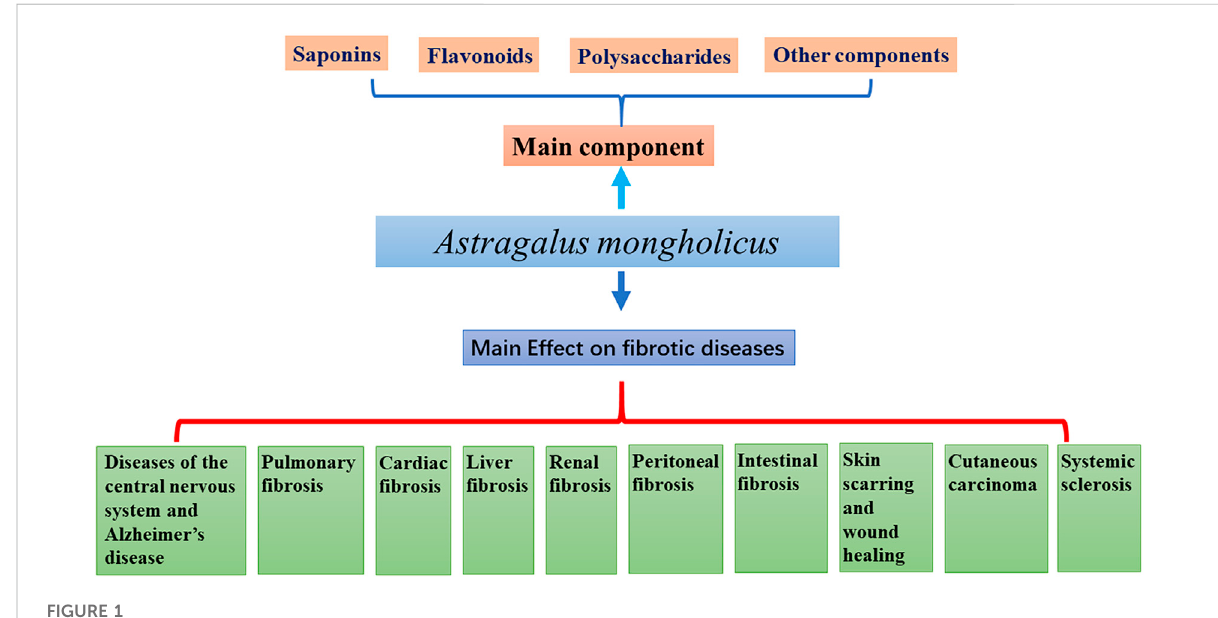
FIGURE 1 Schematic representation of this